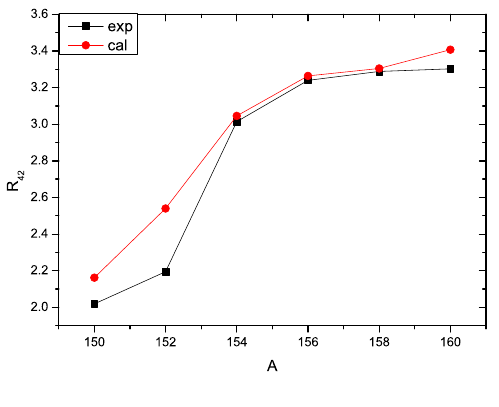
Figure 5. (Color online) Comparison of two calculations for the first 2 + energy for 150 − 160 Gd: black squares corresponding to the full GCM calculation and red dots to the calculation with a fixed deformation.